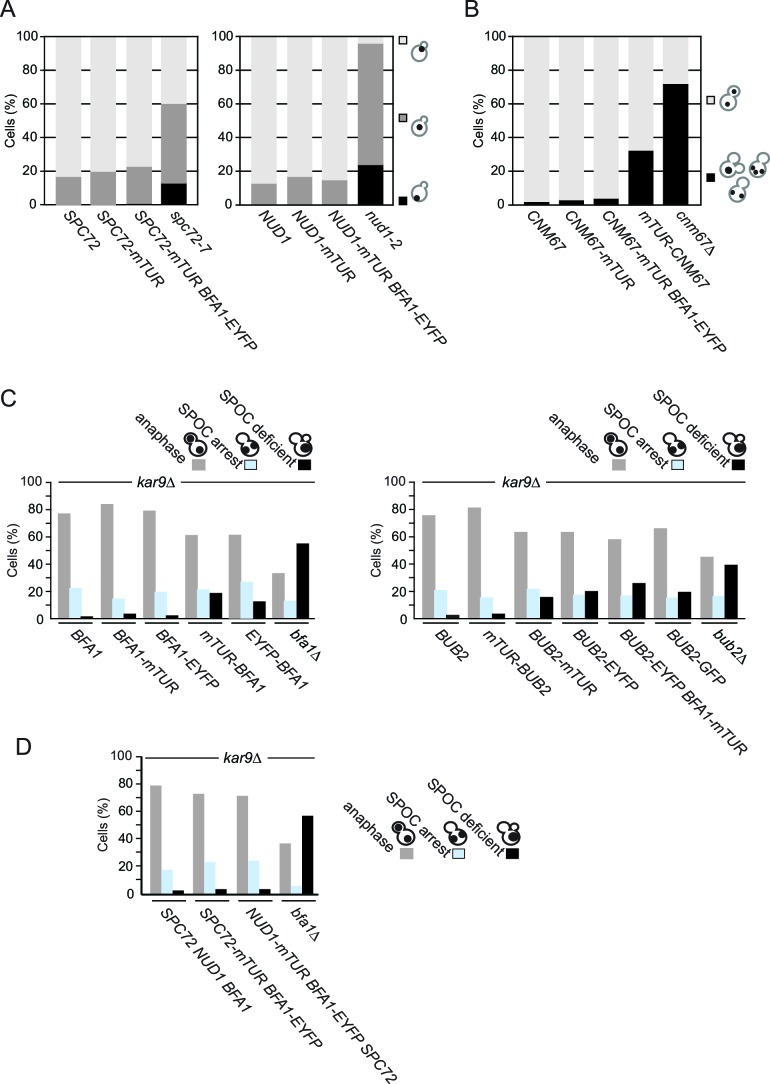
Functionality of tagged SPB proteins and SPOC components.(A) Fluorescent C-terminal fusions of Nud1 and Spc72 are functional. The indicated cell types were grown at 23°C and then shifted to 30°C for 3 hr before fixation and DAPI staining. Graphs show the percentages of cells with the nuclei positioned as depicted in the cartoon to the left. Light grey bars represent correct nuclear positioning (at the bud neck region). N: 200 cells per strain. (B) Cnm67 fusion proteins are functional. Anaphase nuclear positioning was analyzed for wild type (CNM67) and CNM67 tagged strains as depicted. CNM67 deleted cells have a strong defect in anaphase spindle positioning and were used as a positive control. N: 200 cells per strain. Please note that cnm67∆ doesn’t have nuclear positioning defects early in the cell cycle (Grava et al., 2006) (our unpublished data). (C–D) Functionality of SPOC in kar9∆ cells carrying Bfa1, Bub2 (C) and Nud1, Spc72 (D) fused with the indicated fluorophores. The indicated cell types were grown at 23°C and shifted to 30°C for 3 hr to induce the accumulation of cells with misaligned spindles (blue bars). Black bars indicate the SPOC deficient phenotypes as a result of cell cycle progression despite spindle orientation defects. N: 200 cells per strain. One representative graph out of three independent experiments is shown.